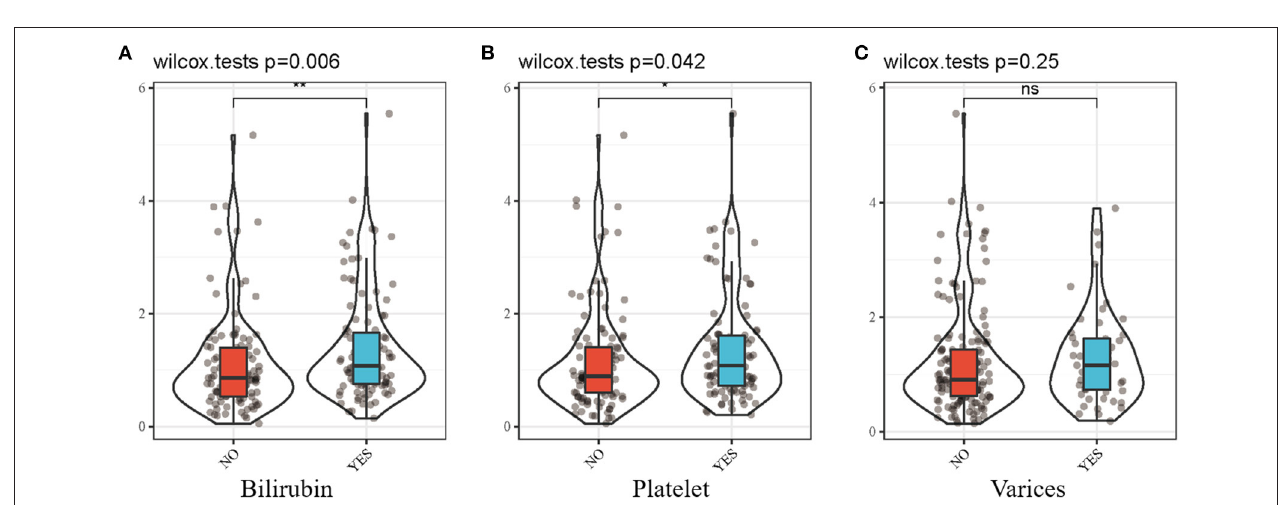
FIGURE 4 | Differential analysis between risk score and clinicopathological features. (A) risk score and bilirubin. (B) risk score and platelet. (C) risk score and varices. Bilirubin, bilirubin ≥ 1.0mg/dl; Platelet, platelet < 100,000/mm 3 ; Varices, presence of varices. * p < 0.05; ** p <